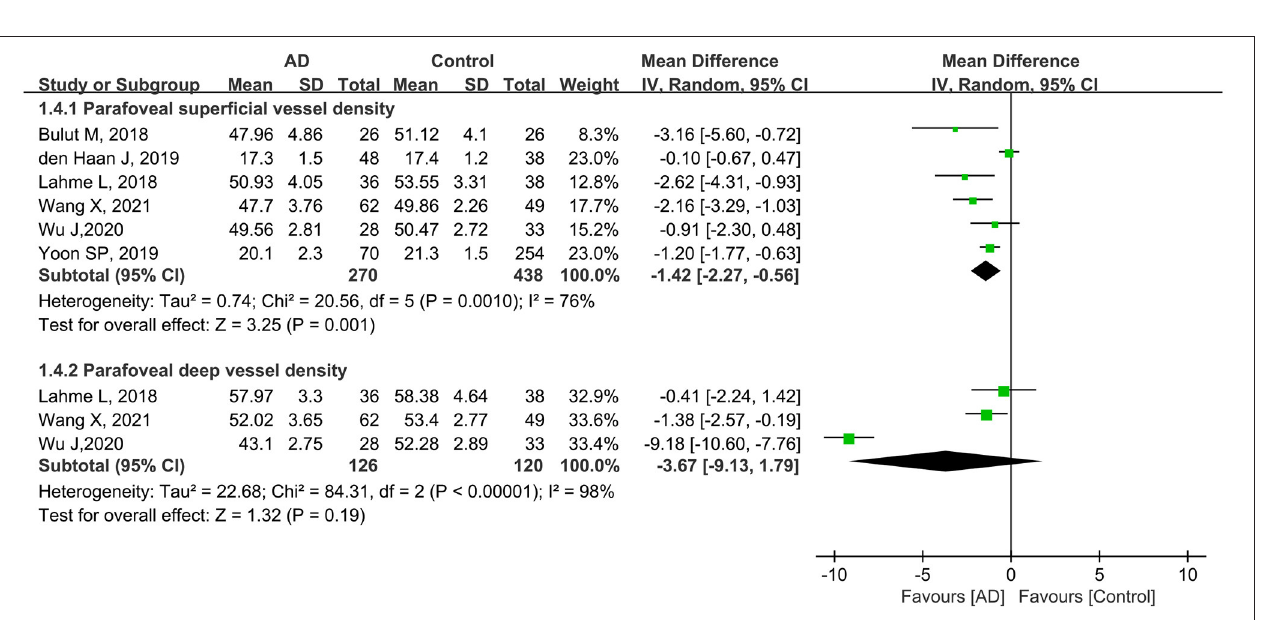
FIGURE 5 | Forest plot of parafoveal superficial and deep vessel density in AD patients and controls.